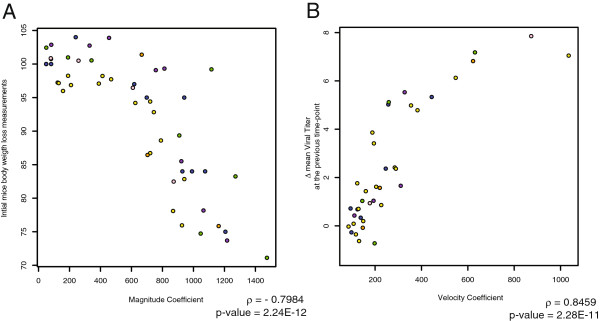
Spearman’s coefficients between MC and body weight, and between VC and titer changes. (A) Scatter plot between the Magnitude Coefficients and the mice body weight loss measurements. (B) Scatter plot between the Velocity Coefficients and the changes in viral titer measurements at the previous time-point. Each dot represents a couple of values for a single biological condition and is colored in order to indicate the viral strain according to the nomenclature of Figure 1. For each scatter plot the Spearman’s coefficient of correlation is indicated as well as the associated p-value.